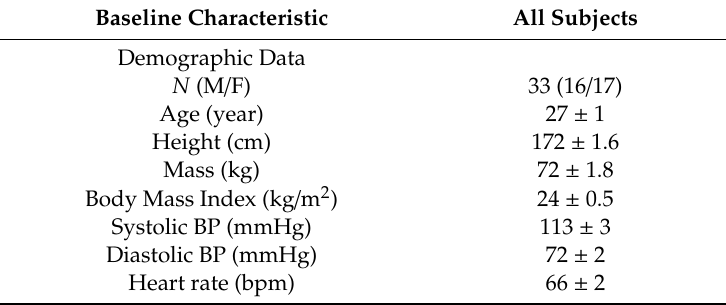
Table 1. Baseline subject